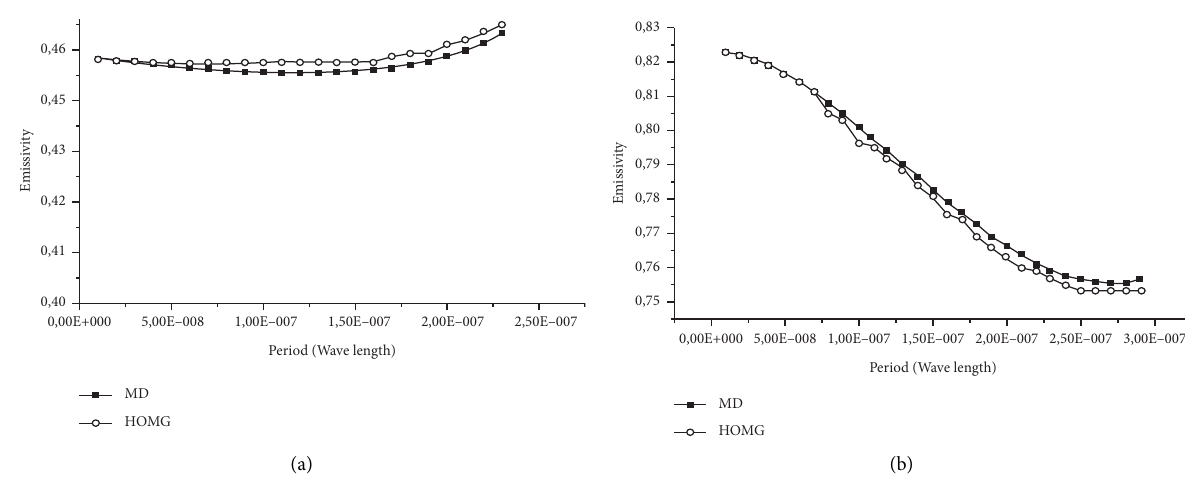
lim function of ( h / λ )cos θ .